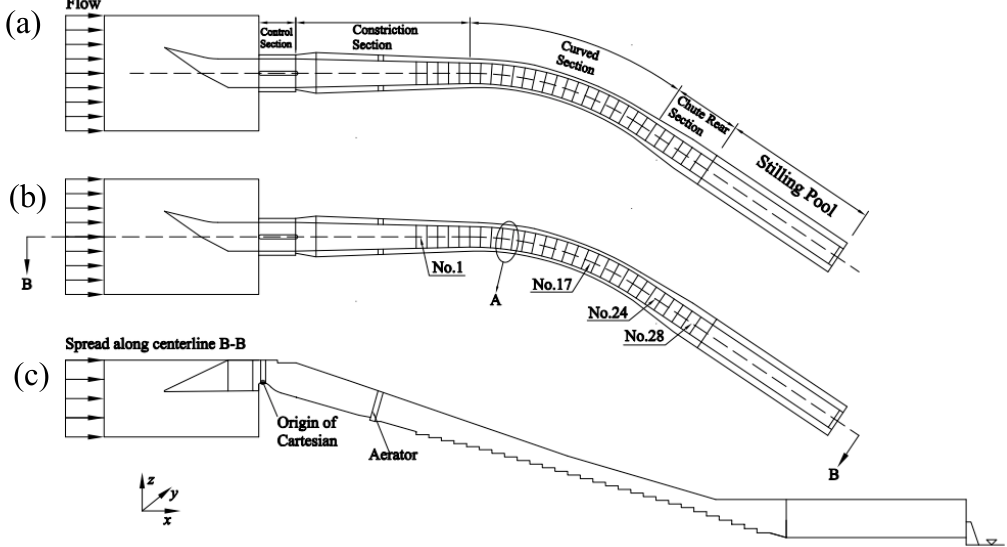
Figure 1. Diagram of a reservoir spillway. ( a ) Top view of smooth spillway; ( b ) top view of stepped